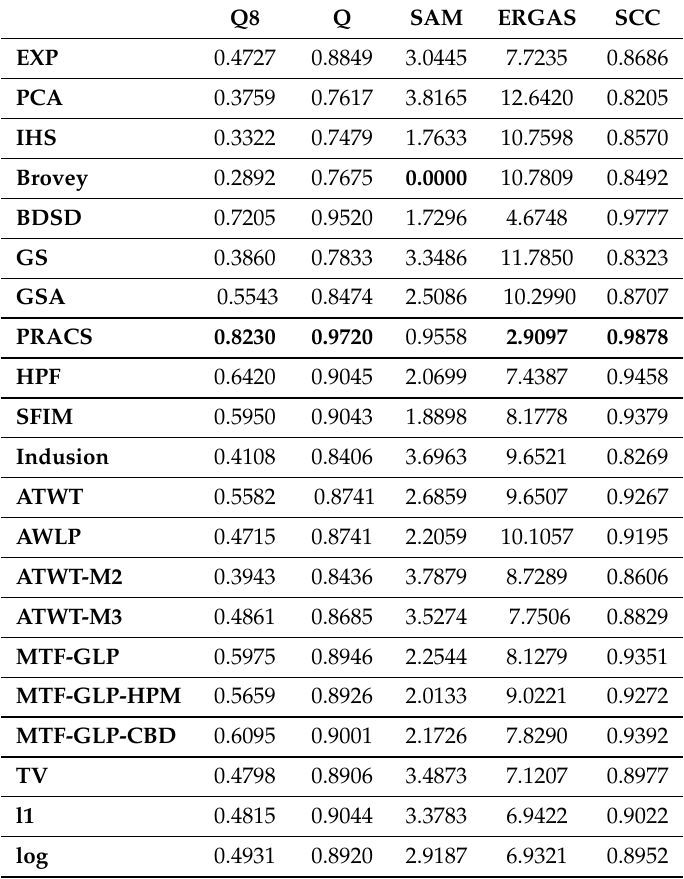
Table 5. Quantitative results using Wald’s protocol on the LANDSAT 7-ETM+ Netherland image in Figure 2a. Bold values indicate the best